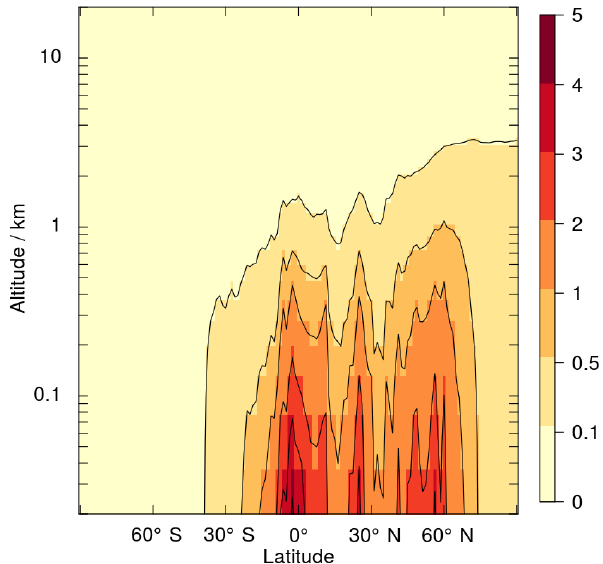
Figure 8. Annual zonal mean of the OH reactivity (in s − 1 ) arising from sink